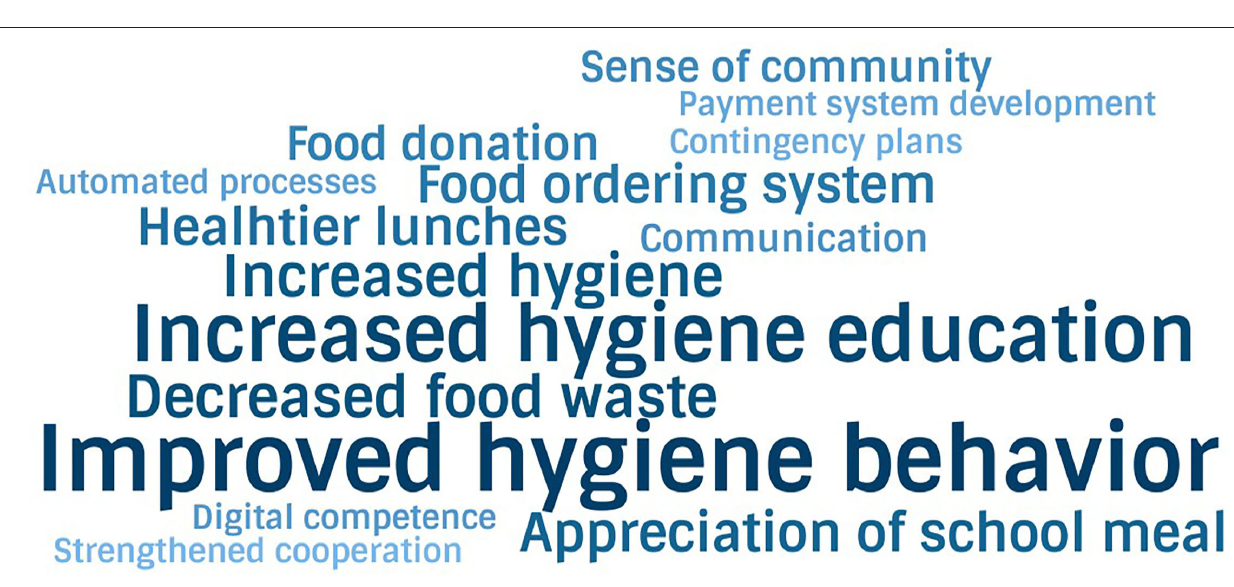
FIGURE 5 | A word cloud for the reported BSR solutions and developments. Source: own analysis based on